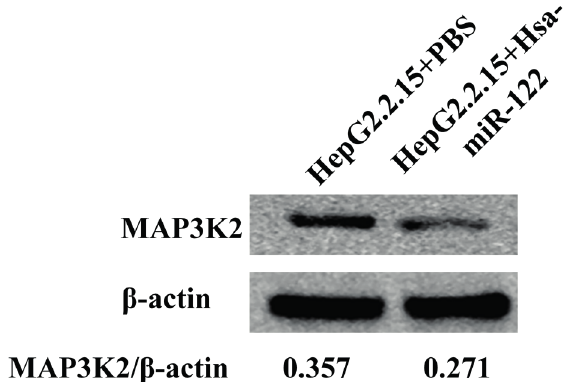
Figure 5 - Western Blot assay. The WB analysis of MAP3K2 expression in the blood samples from control group were significantly higher than the samples from observer